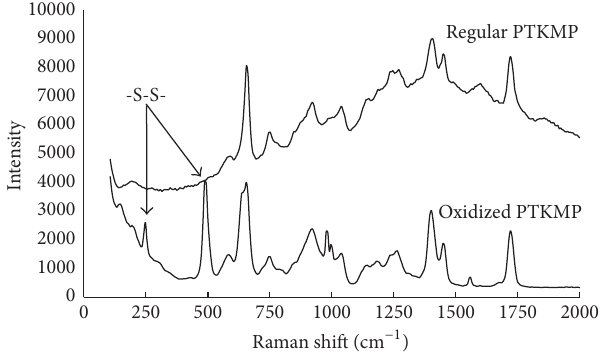
Figure 3: Raman spectra of the regular and oxidized